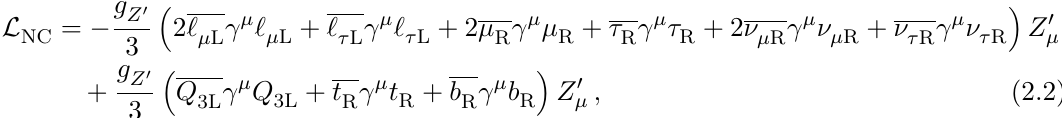
, the modified covariant derivative can be written µ